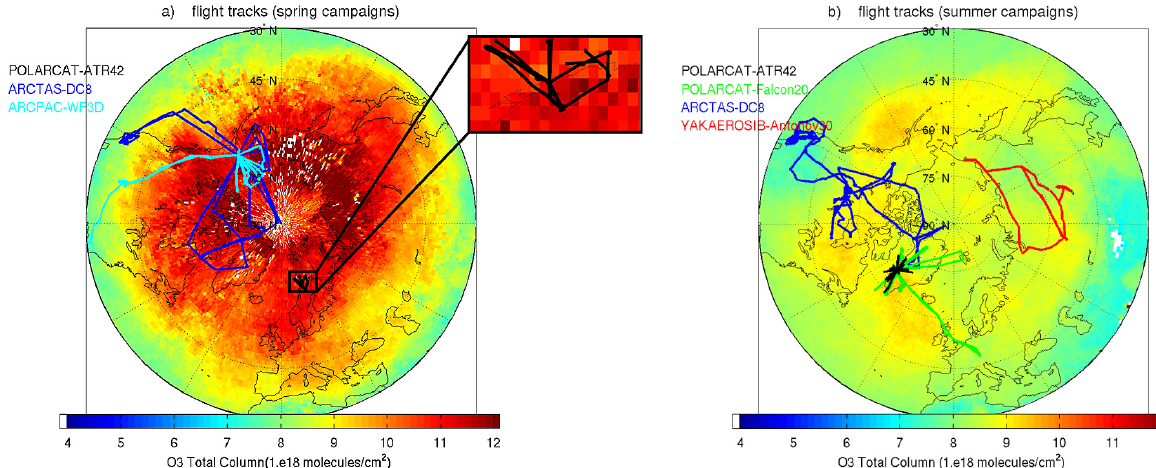
Fig. 1. Global distributions of daytime IASI total O 3 columns averaged from 18 March to 23 April 2008 (period of POLARCAT spring campaigns) with a zoom on ATR-42 flight area (a) and for 18 June to 29 July 2008 (period of POLARCAT summer campaigns) (b) . IASI data are averaged over a 1 ◦ × 1 ◦ grid. White areas indicate no data. Flight-tracks for all flights of the DC-8 (blue), ATR-42 (black), WP-3D (cyan), Falcon-20 (green) and Antonov-30 (red) aircraft are superimposed on the maps.